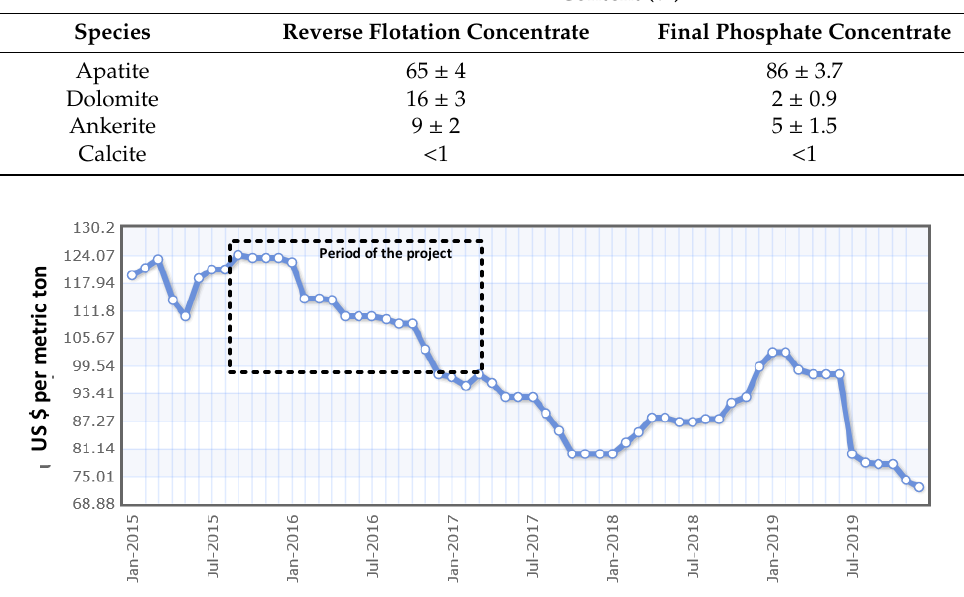
Figure 5. Price of phosphate concentrate [27].